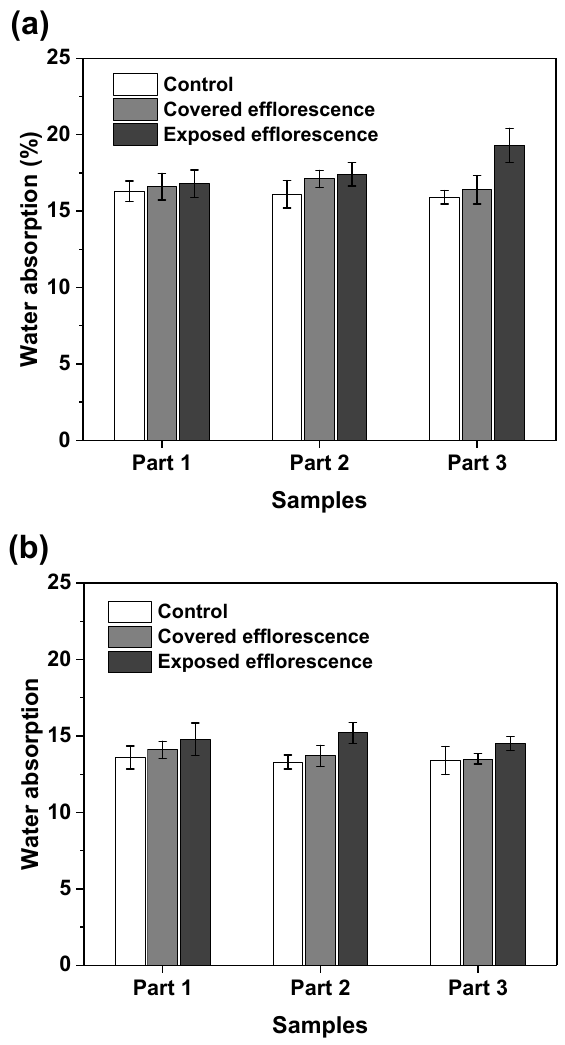
Figure 8. Water absorption of ( a ) NHFS and ( b ) NSFS samples.